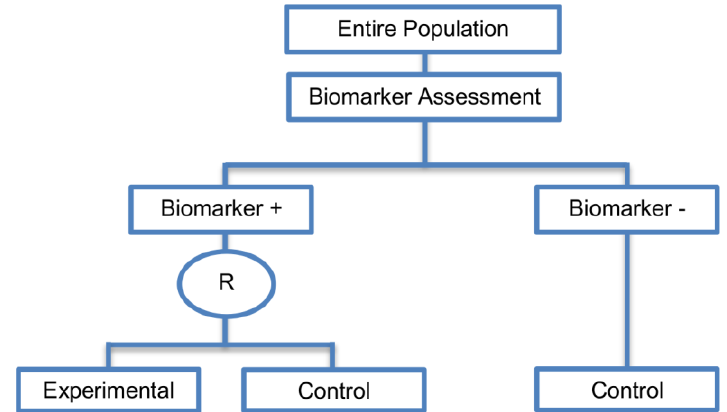
Figure 11. Hybrid design. “R” refers to randomizat ion of patients.